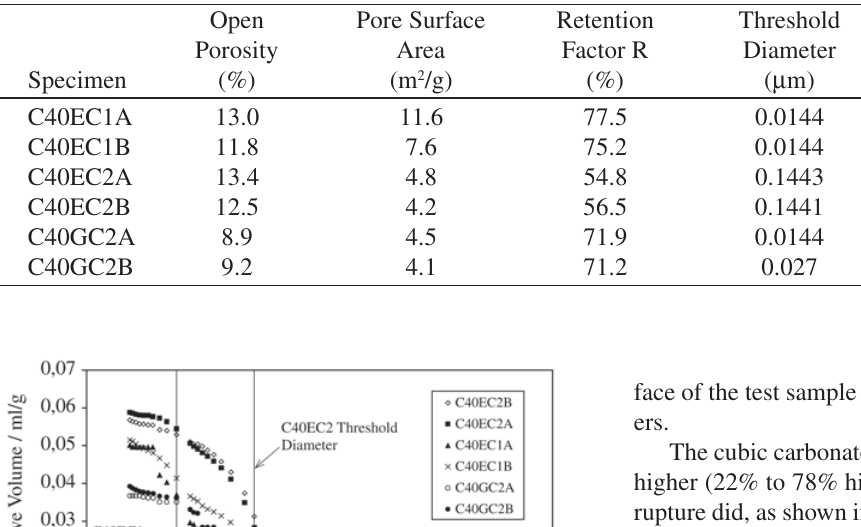
Table 7. Parameters Obtained with Mercury Intrusion Porosimetry.